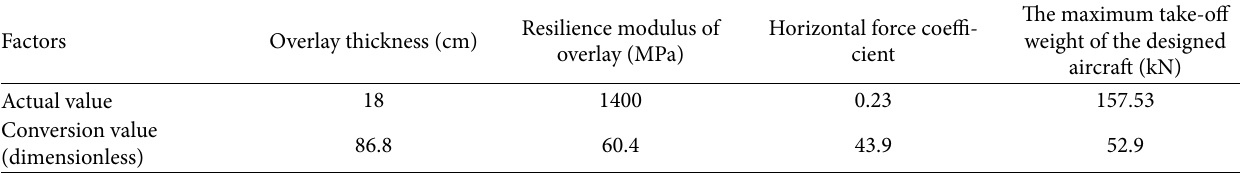
Table 17: Single-factor values of Juba airport in South